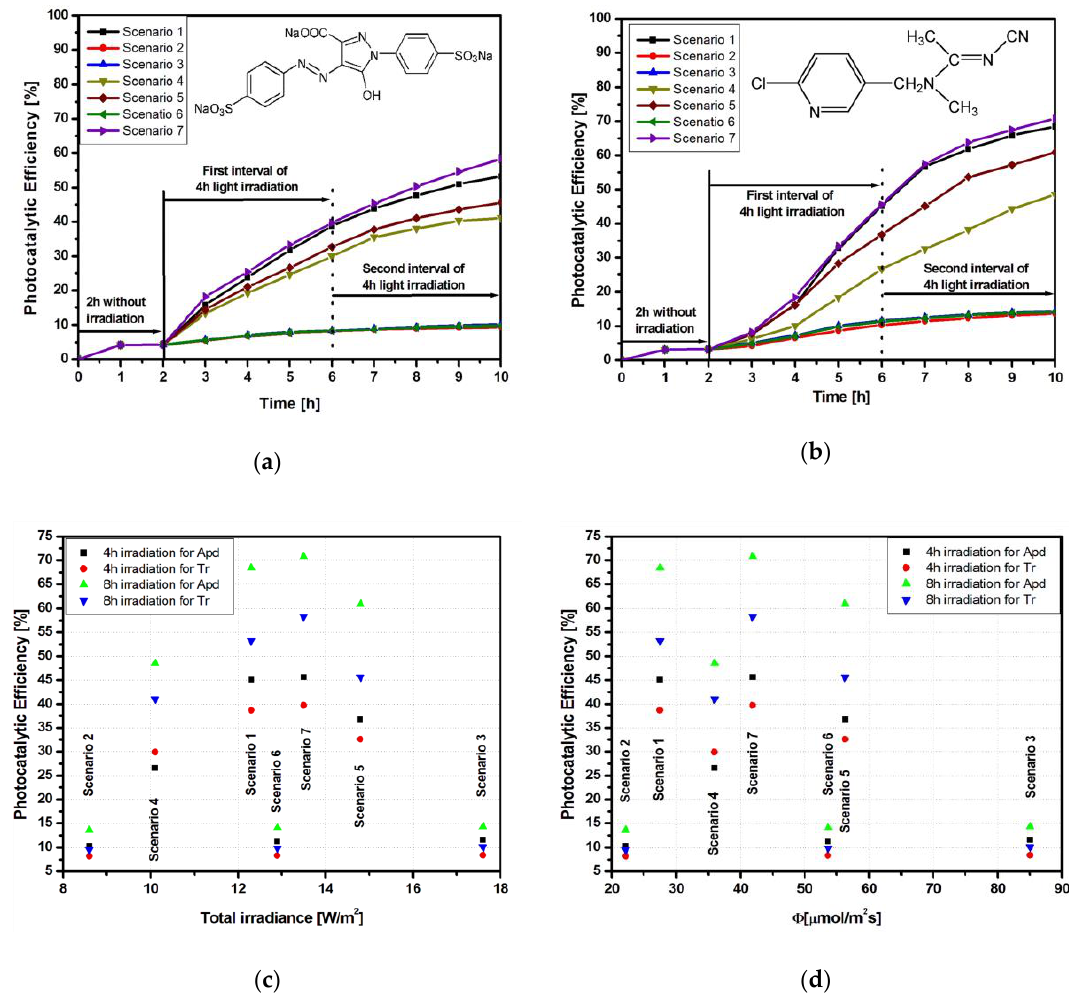
Figure 4. Photocatalytic parameters of the Ti_FTO sample: ( a ) Tr photodegradation, ( b ) Apd photodegradation, ( c ) total irradiance vs. photocatalytic e ffi ciency, and ( d ) photon flux vs. photocatalytic e ffi ciency.